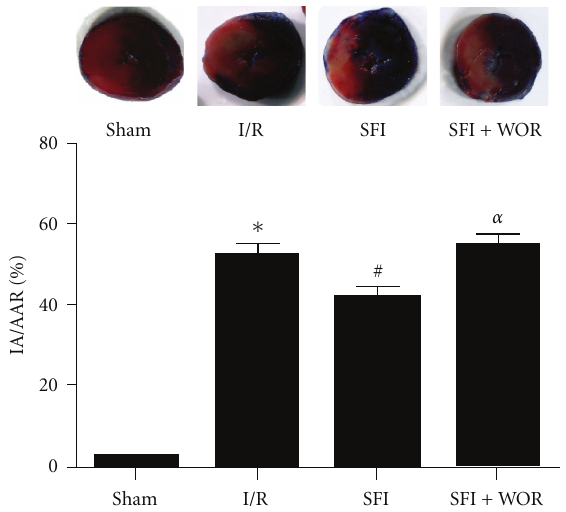
Figure 2: Myocardial infarct size in Sham-operated rats or in rats subjected to 30 min ischemia followed by 2h of reperfusion. The blue-stained areas represent nonischemic tissue, and red- stained areas represent the area at risk. Pale areas indicate infarct areas. Values presented are mean ± SEM. AAR: area at risk; IA: infarct area; I/R: ischemia/reperfusion; SFI: Shen-fu injection; WOR: wortmannin. n = 6, ∗ P < . 05 versus Sham, # P < . 05 versus I/R, and α P < . 05 versus